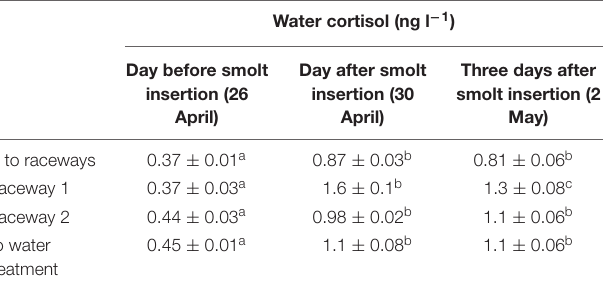
TABLE 2 | Concentrations of cortisol in the rearing water in a commercial RAS for slaughter size salmon the day before, the day after, and 3 days after a smolt insertion period of 3 days.